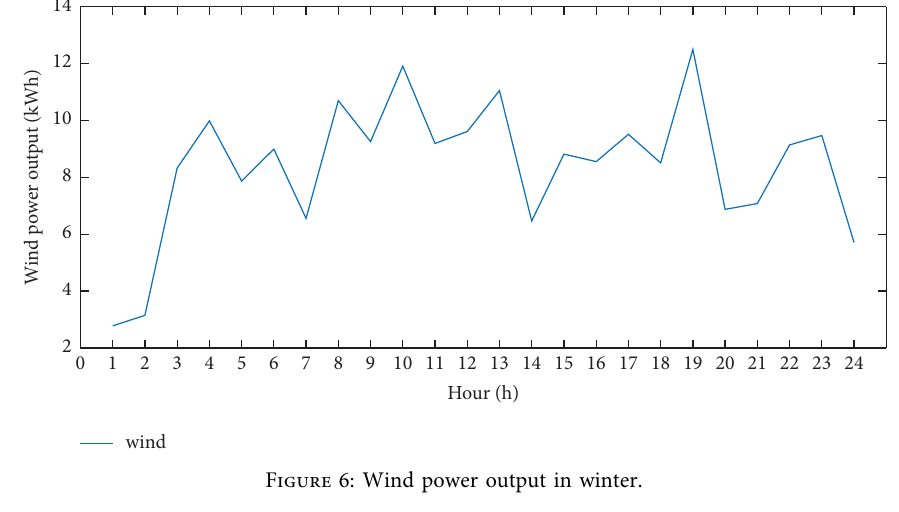
Figure 6: Wind power output in winter.